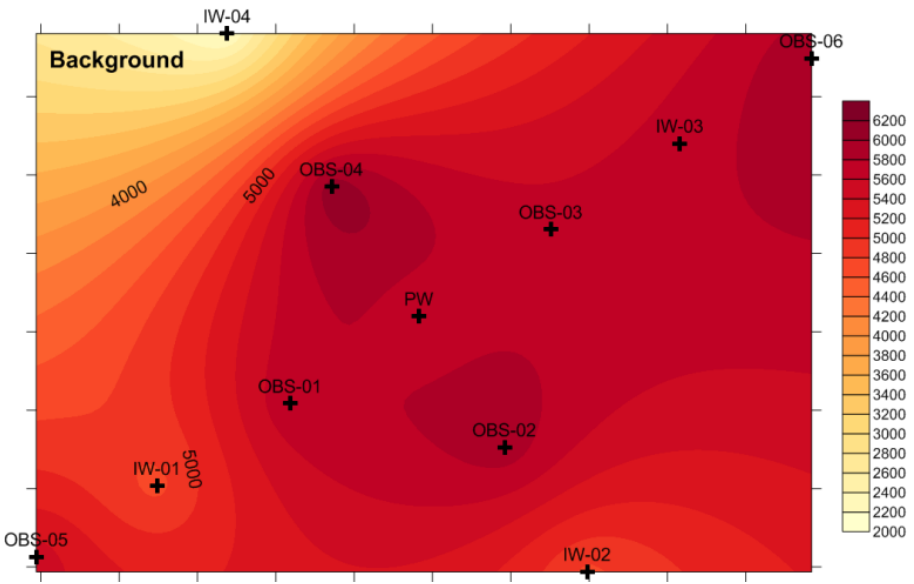
Figure 10. Areal distribution of background EC values (mS/cm) at 25-m depth from the surface in the study area.